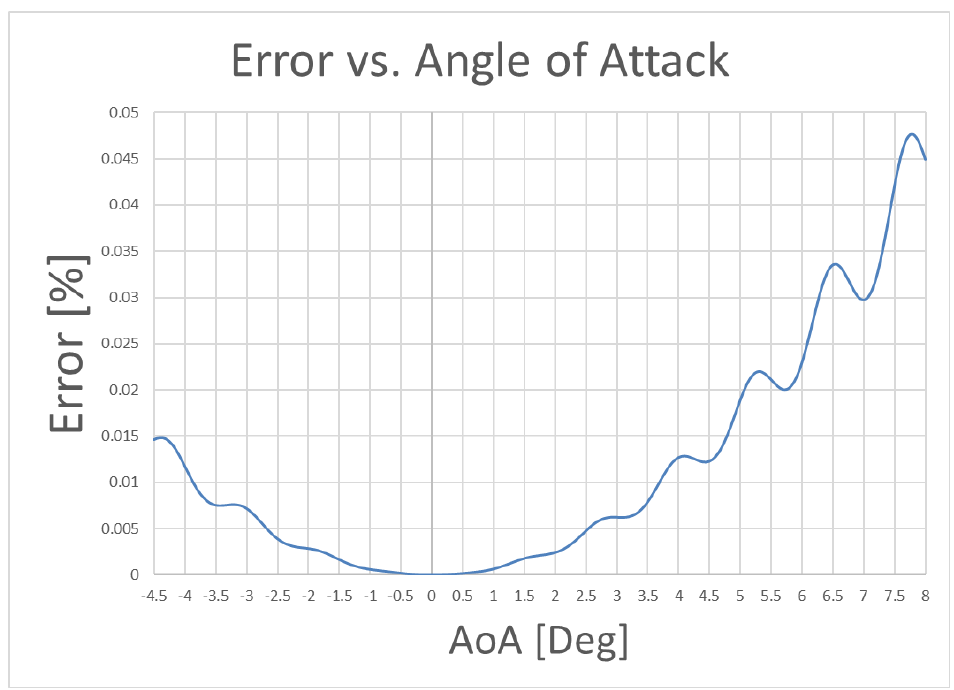
Figure 13. Error between the exact solution and the approximate solution vs angle of attack.